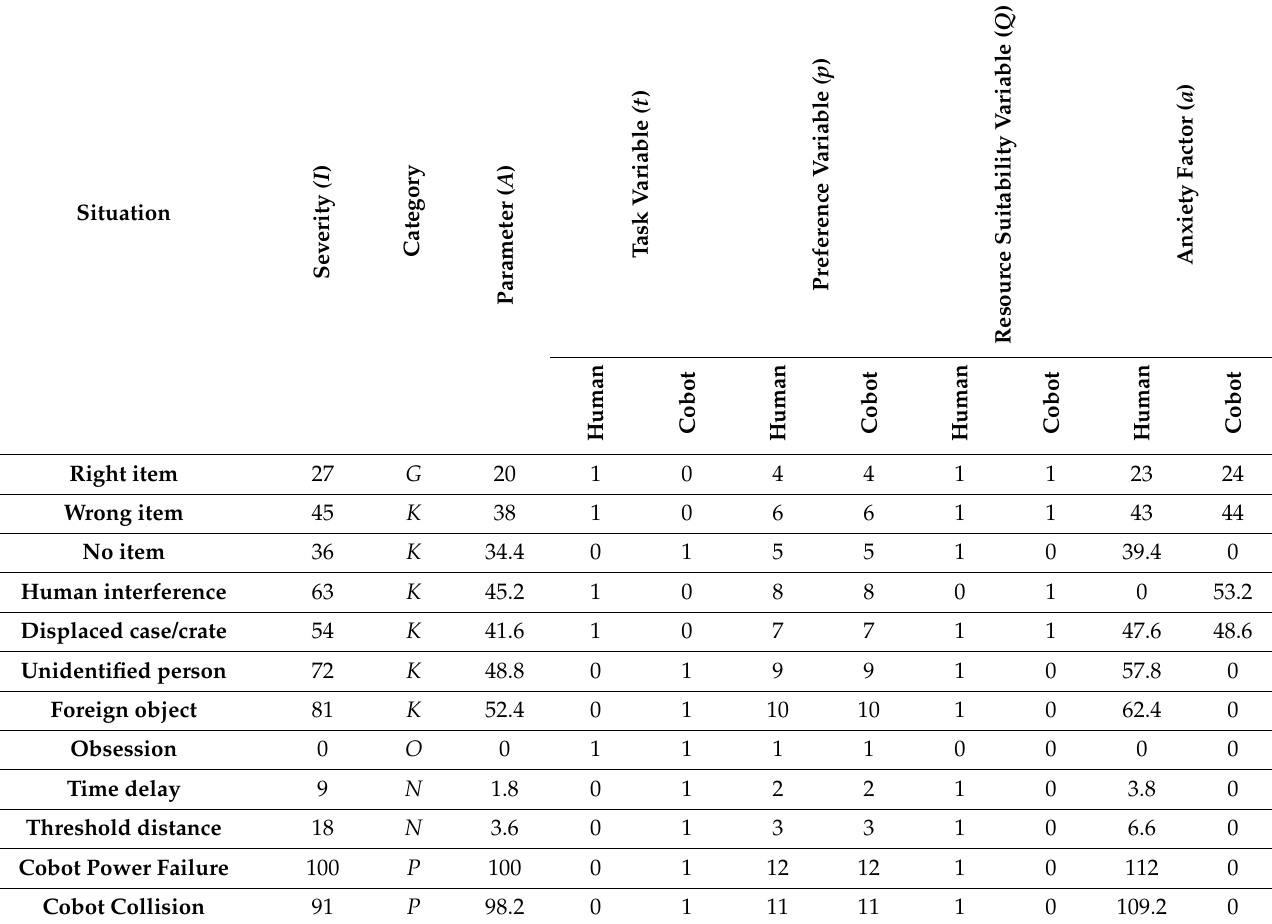
Table 3. Expected situations, their anxiety, variables, and anxiety